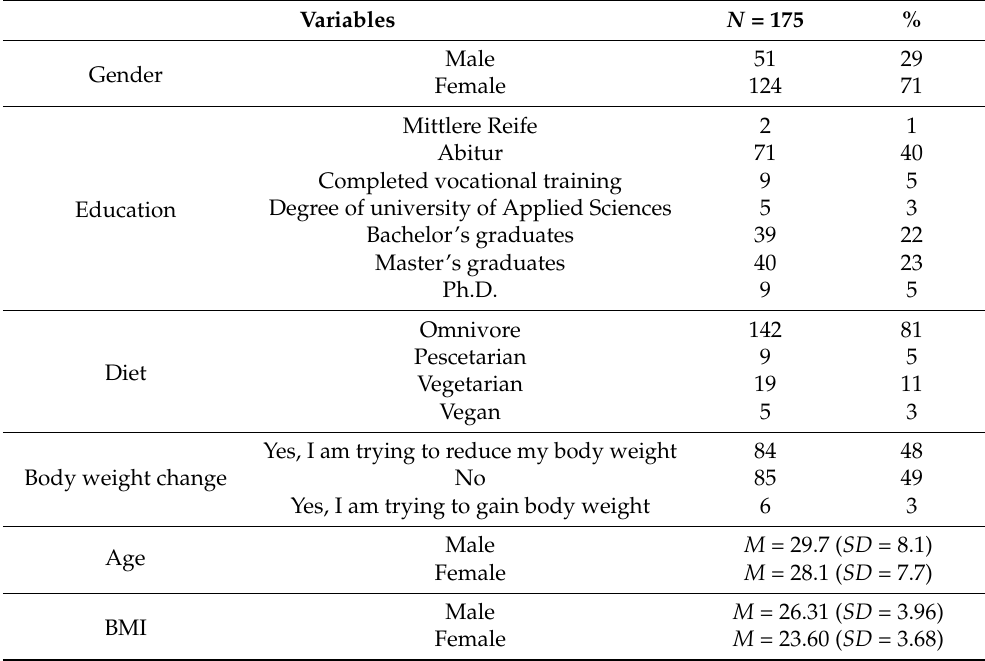
Table 2. Sociodemographic characteristics of